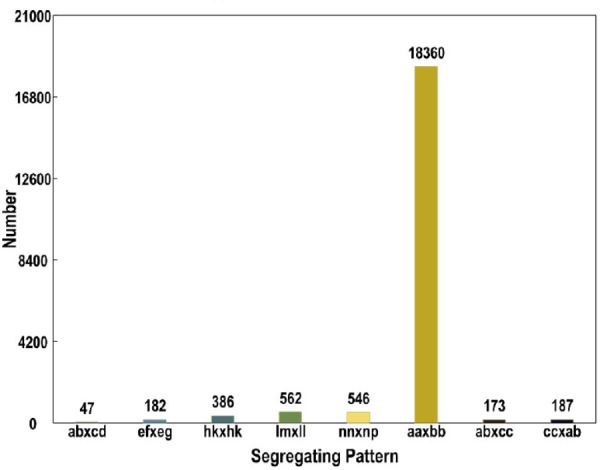
Genotype distribution of SLAF markers. The Y axis represents the number of SLAFs, the X axis represents the type of SLAFs.